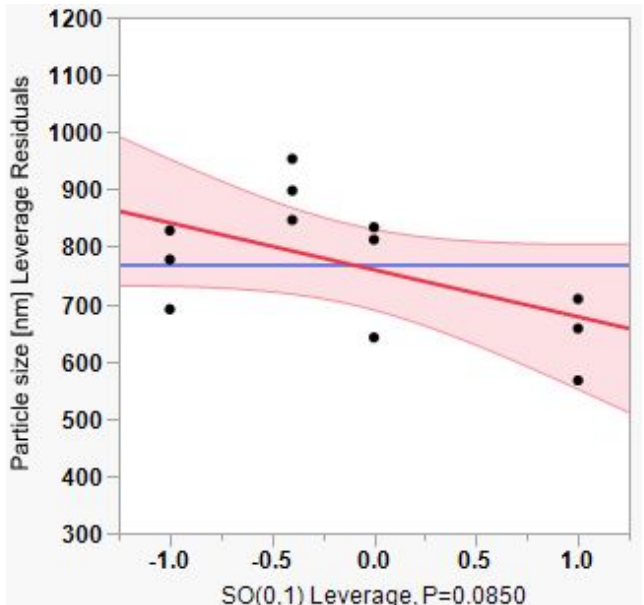
Figure 8. Leverage plot for sunflower oil (SO).